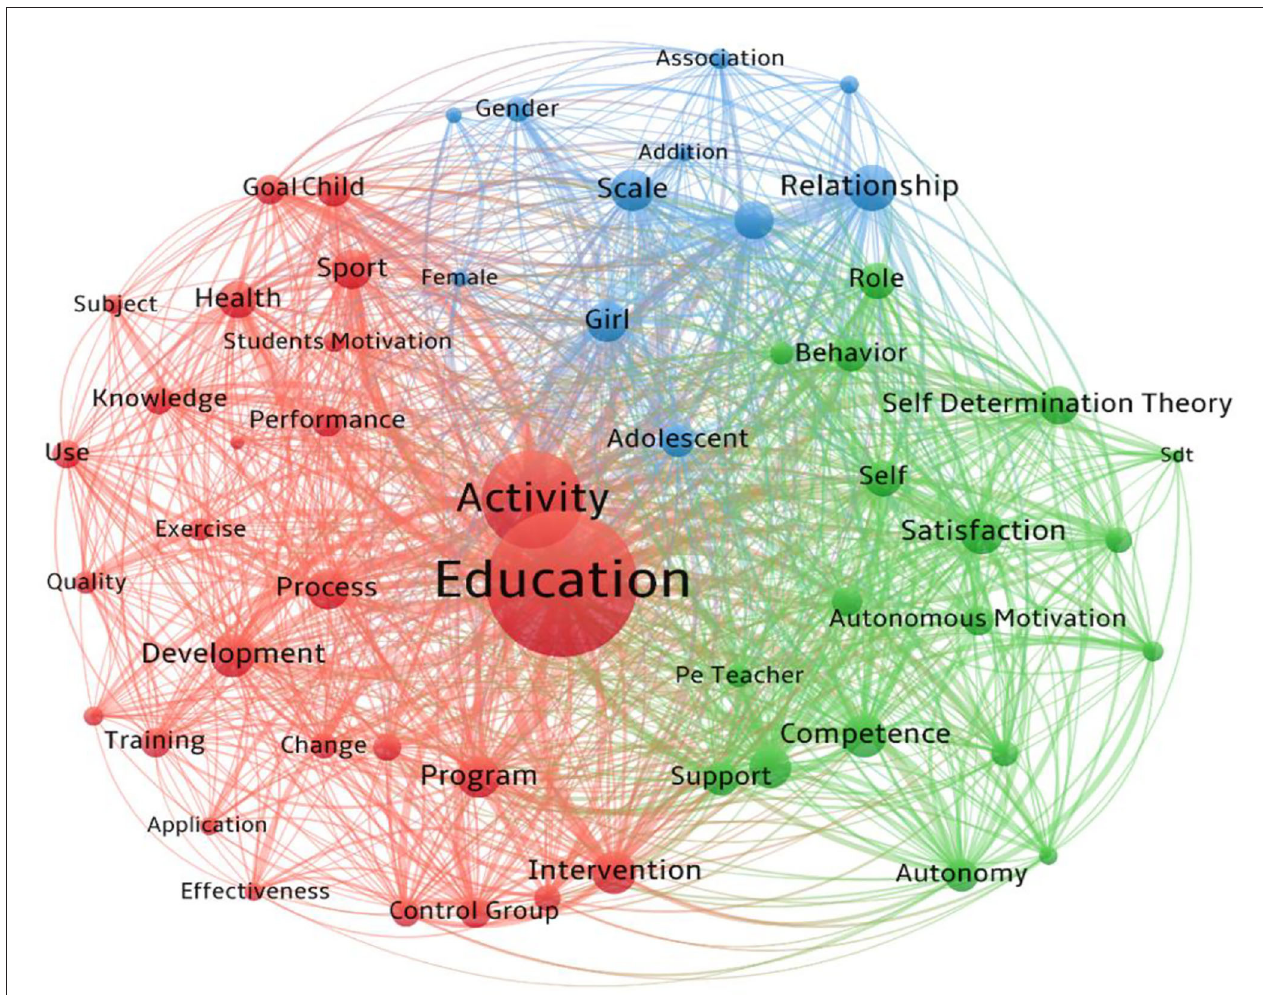
FIGURE 8 | Co-occurrence network